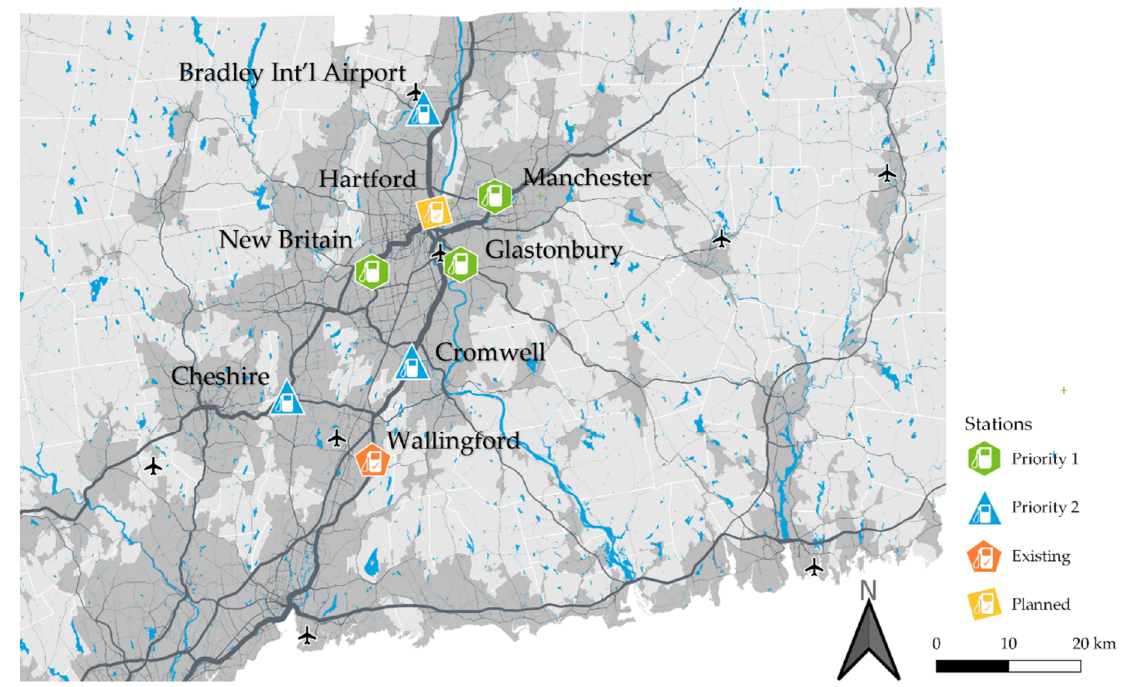
Figure 7. Map showing existing, under-construction, and final set of recommended stations.